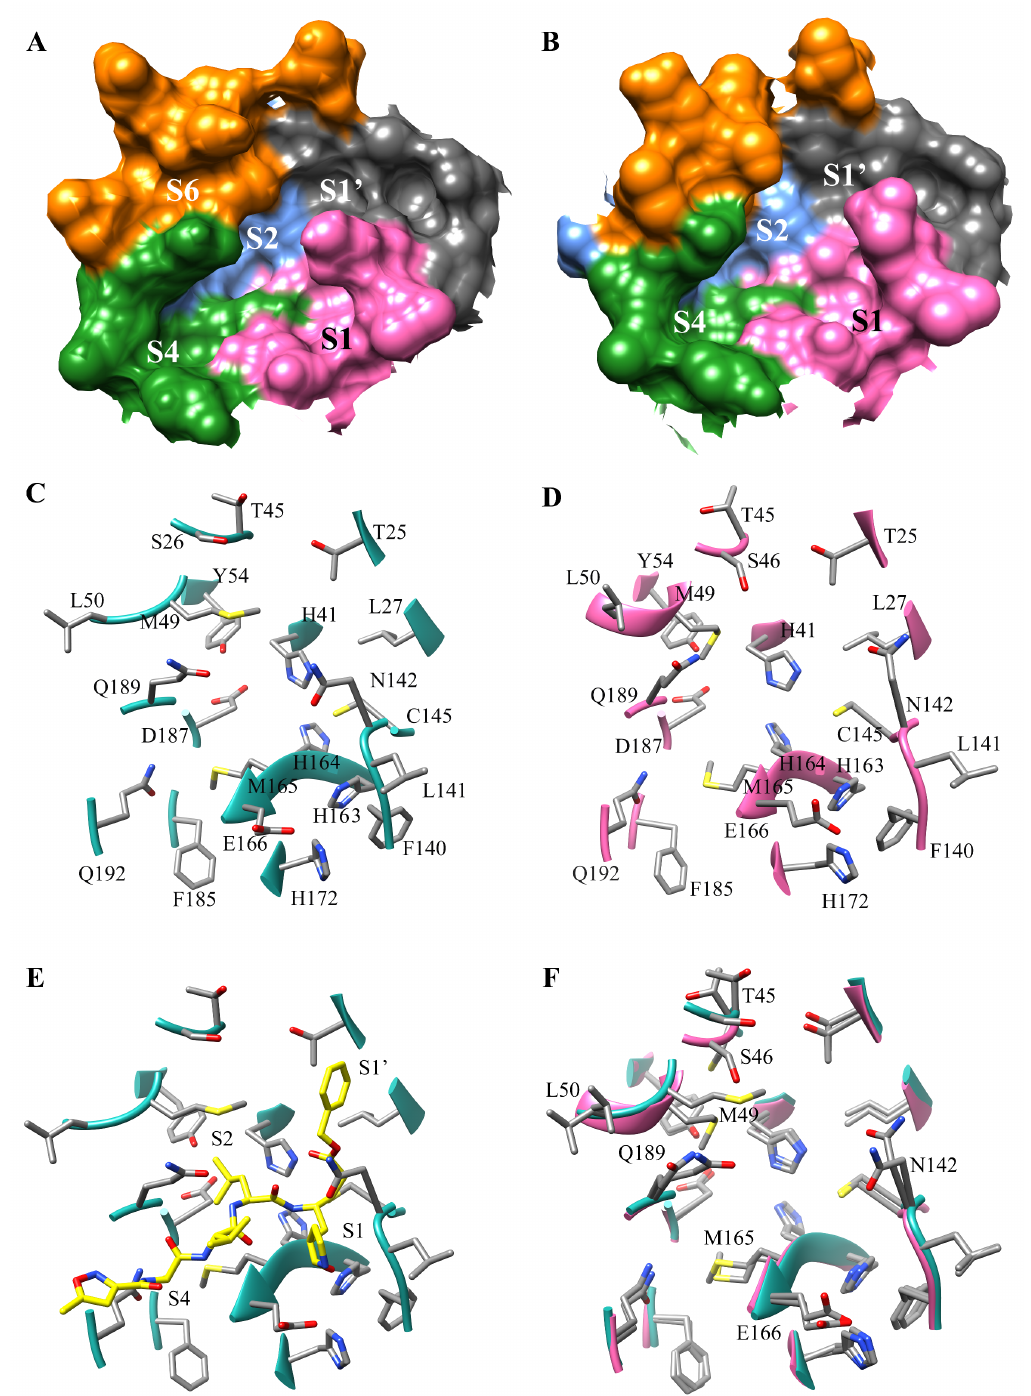
Figure 1. Overview of SARS-CoV-2 Active site using PDB 6LU7 and 5R7Z: ( A ) Surface of SARS-CoV-2 M pro active site in PDB 6LU7, regions colored represent the binding subsites S1, S1 (cid:48) , S2, S4, and the cleft S6, which is accessible in the 6LU7 receptor; ( B ) Surface of SARS-CoV-2 M pro active site in PDB 5R7Z, regions colored represent the binding subsites S1, S1 (cid:48) , S2, S4. ( C ) Residues comprise the key active site regions in SARS-CoV-2 M pro (PDB 6LU7); ( D ) Residues which make of the key active site regions in SARS-CoV-2 M pro (PDB 5R7Z); ( E ) The ribbon structure of the 6LU7 crystal structure of SARS-CoV-2 M pro showing residues contributing to the S1, S2, S4 subsites. The N3 inhibitor is shown to assist in visualizing the subsite binding pockets. ( F ) Overlay of the 6LU7 (cyan) and the 5R7Z (pink) active sites. The highlighted residues are the residues shown to have di ff erent side-chain